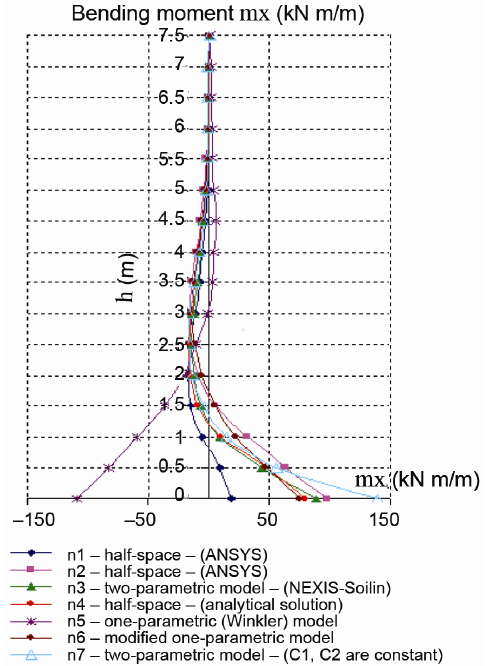
Fig. 9. Bending moments along the cylindrical tank walls Table 1. Results of the measurements